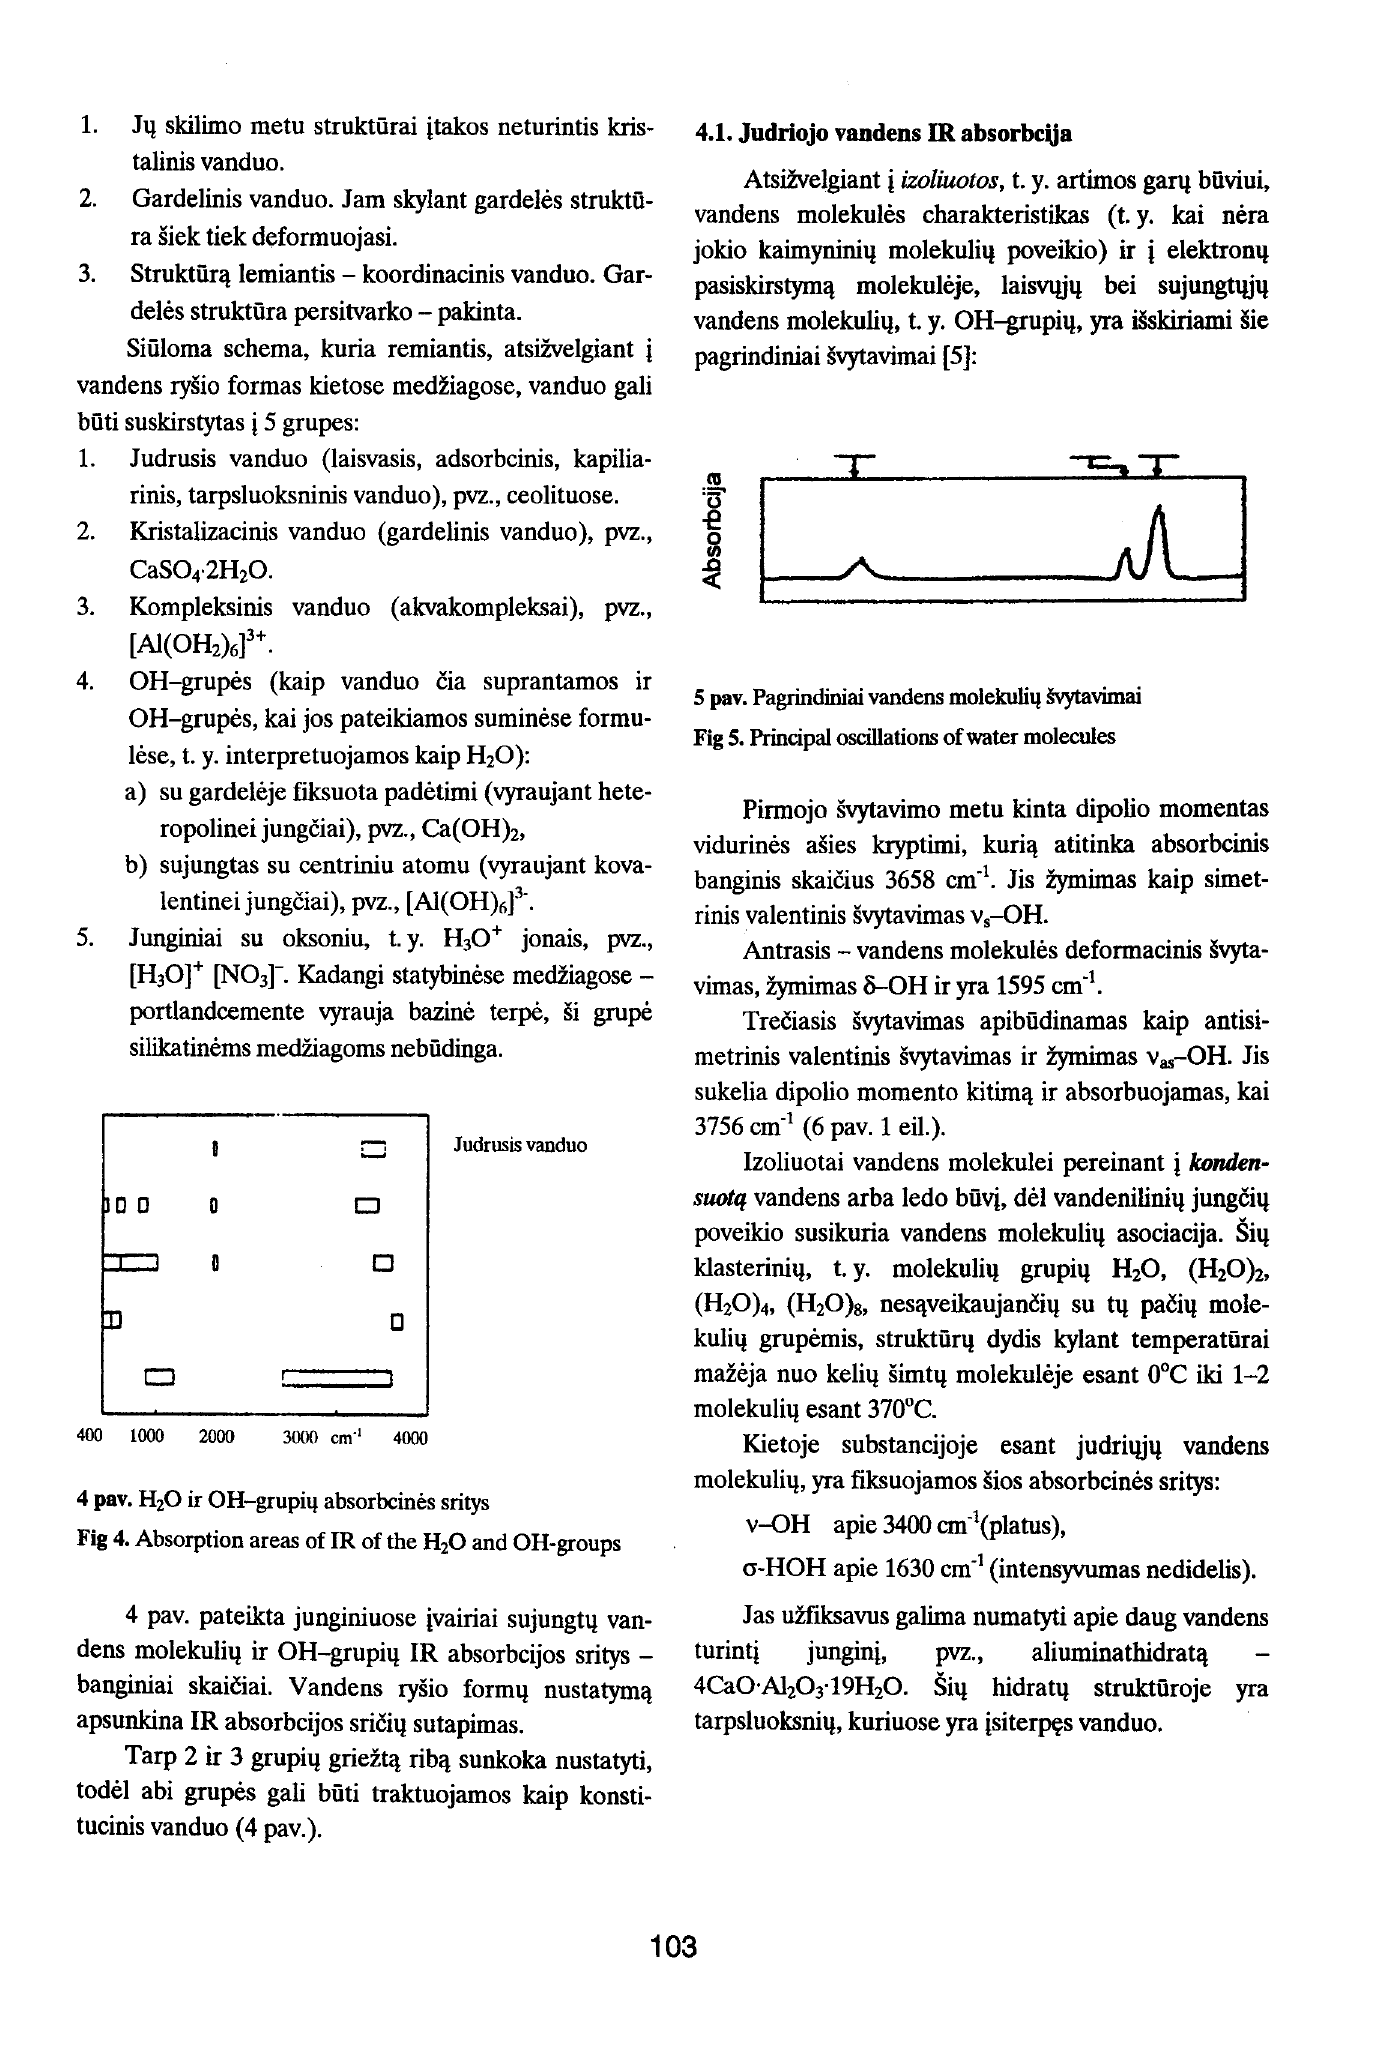
Fig 5. Principal oscillations of water molecules Pirmojo svytavimo metu kinta dipolio momentas vidurines asies kryptimi, kuri<l atitinka absorbcinis banginis skaicius 3658 cm· 1 . Jis zymimas kaip simet rinis valentinis svytavimas